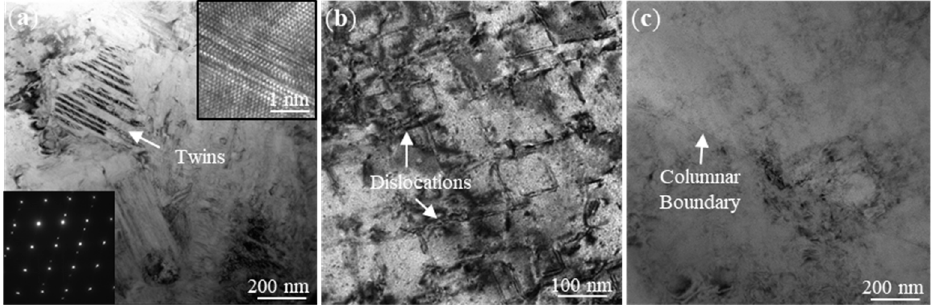
Figure 11. TEM-Bright field micrographs images: ( a ) twins from U3 sample, ( b ) dislocations from U3 sample, ( c ) α -Cu matrix with columnar grain boundary from C3 sample.